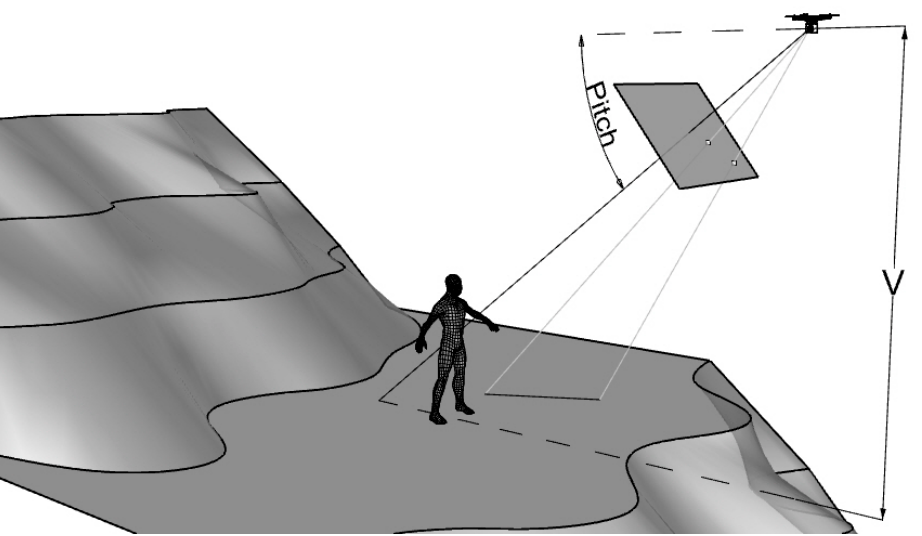
Figure 2. The relative elevation V of the UAV about the position of the target can be retrieved by knowing the distance between the two points visible in the image and lying in the plane of the target. (source: personal collection).